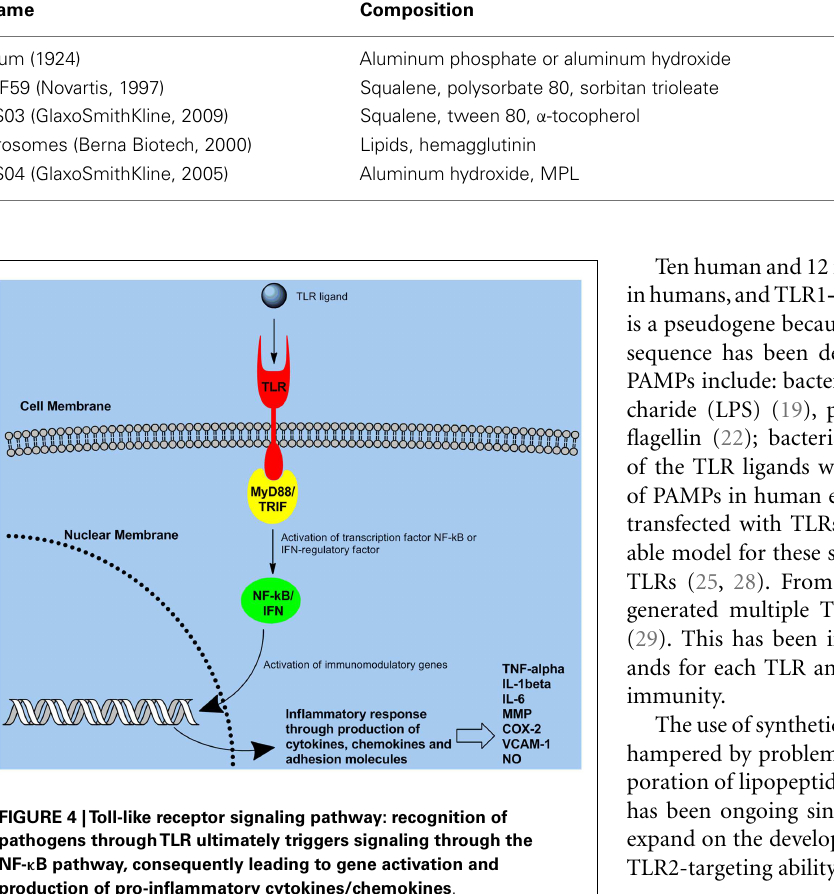
antibody production,and immune responses. TLRs are evolution-